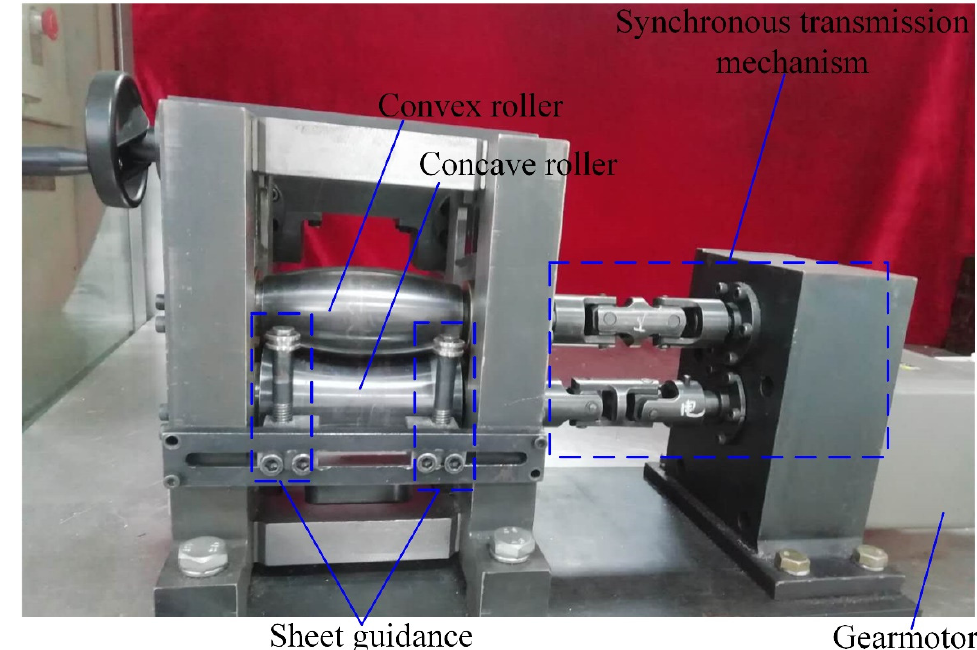
Figure 11. Rolling equipment of 3D curved parts.